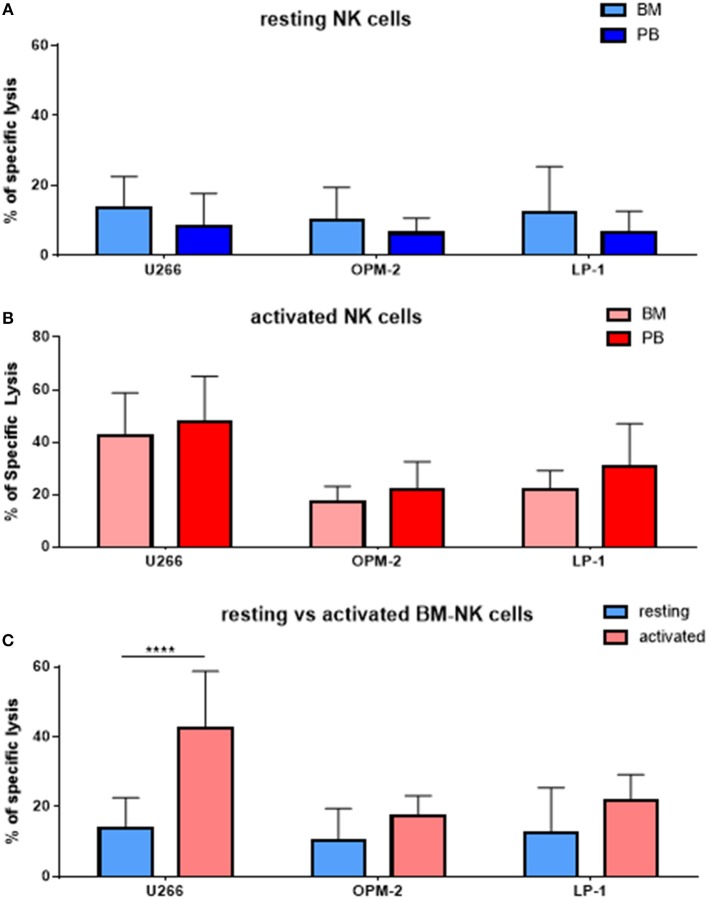
NK cells isolated from peripheral blood or bone marrow exhibit a similar cytotoxic potential and phenotype. (A) Resting and (B) activated NK cells isolated from peripheral blood and bone marrow of patients were co-cultured for 24 h with the CFSE-stained multiple myeloma cell lines LP-1, OPM-2 and U266 to compare the specific lysis of target cells. (C) Comparison of BM NK cytotoxic potential before and after activation. The percentage of dead tumor cells was determined with a live-dead stain (DAPI) via flow cytometry after 24 h of co-culture. For bone marrow samples, 9 individual experiments with resting NK cells and 7 individual experiments with 7 days cytokine activated NK cells were performed (n = 7–9). For peripheral blood samples 10 individual experiments were performed (n = 10). Statistical analysis with two-way ANOVA + Tukey's multiple comparison: *p < 0.05, **p < 0.01, ***p < 0.001, ****p < 0.0001.